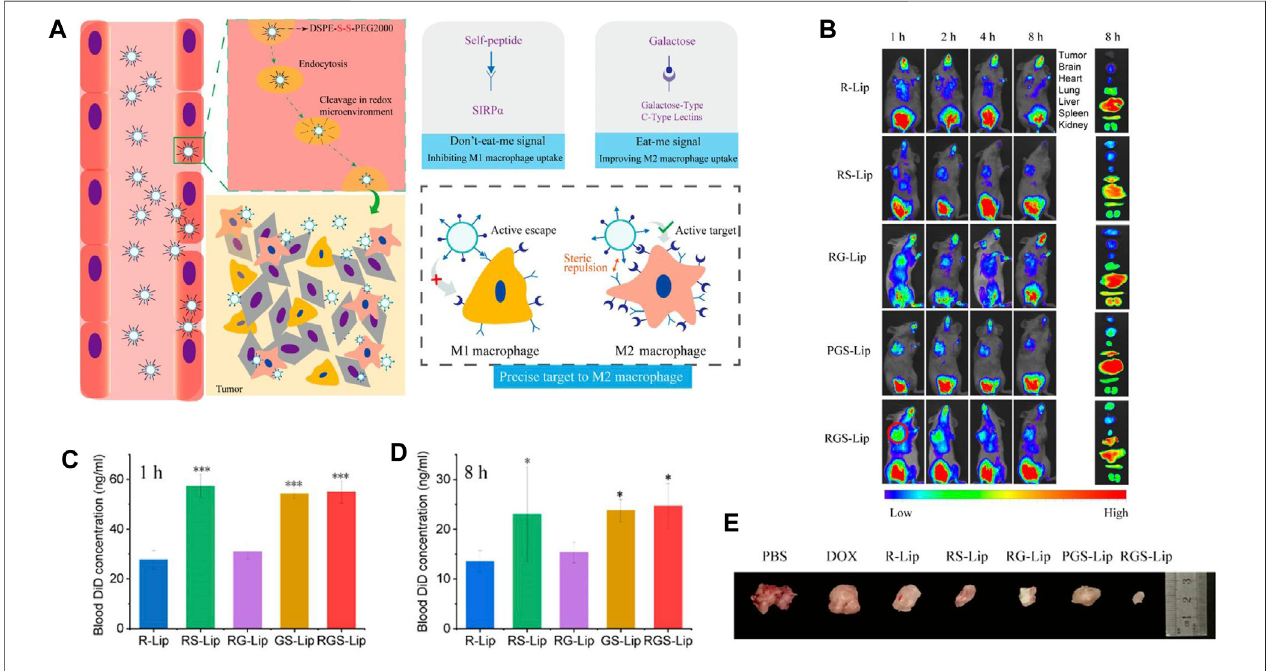
FIGURE5|(A) SchematicdiagramdepictingprecisedeliveryofnanomedicinetoM2macrophages. (B – D) RGS-Lipprolongsthecirculationtimeandincreasesthe accumulation of liposomes in the tumor. (B) In vivo and ex vivo fl uorescence images of liposomes injected into mice. Blood DiD concentration at (C) 1 h and (D) 8 h. (E) Photographs of A20 subcutaneous tumors at the end of treatment. Adapted with permission [98]. Copyright 2020. American Chemical Society.